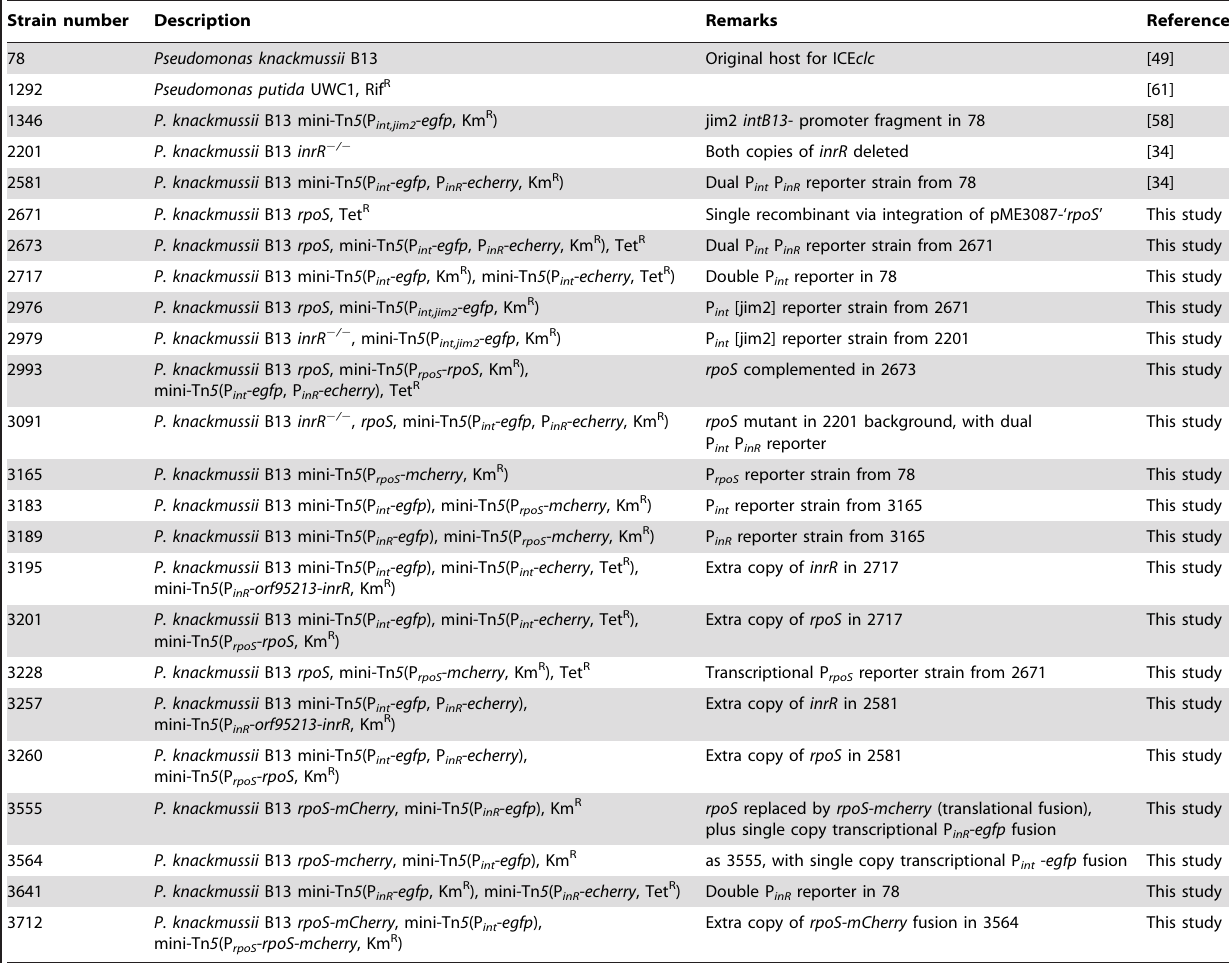
Table 1. Strains used in this